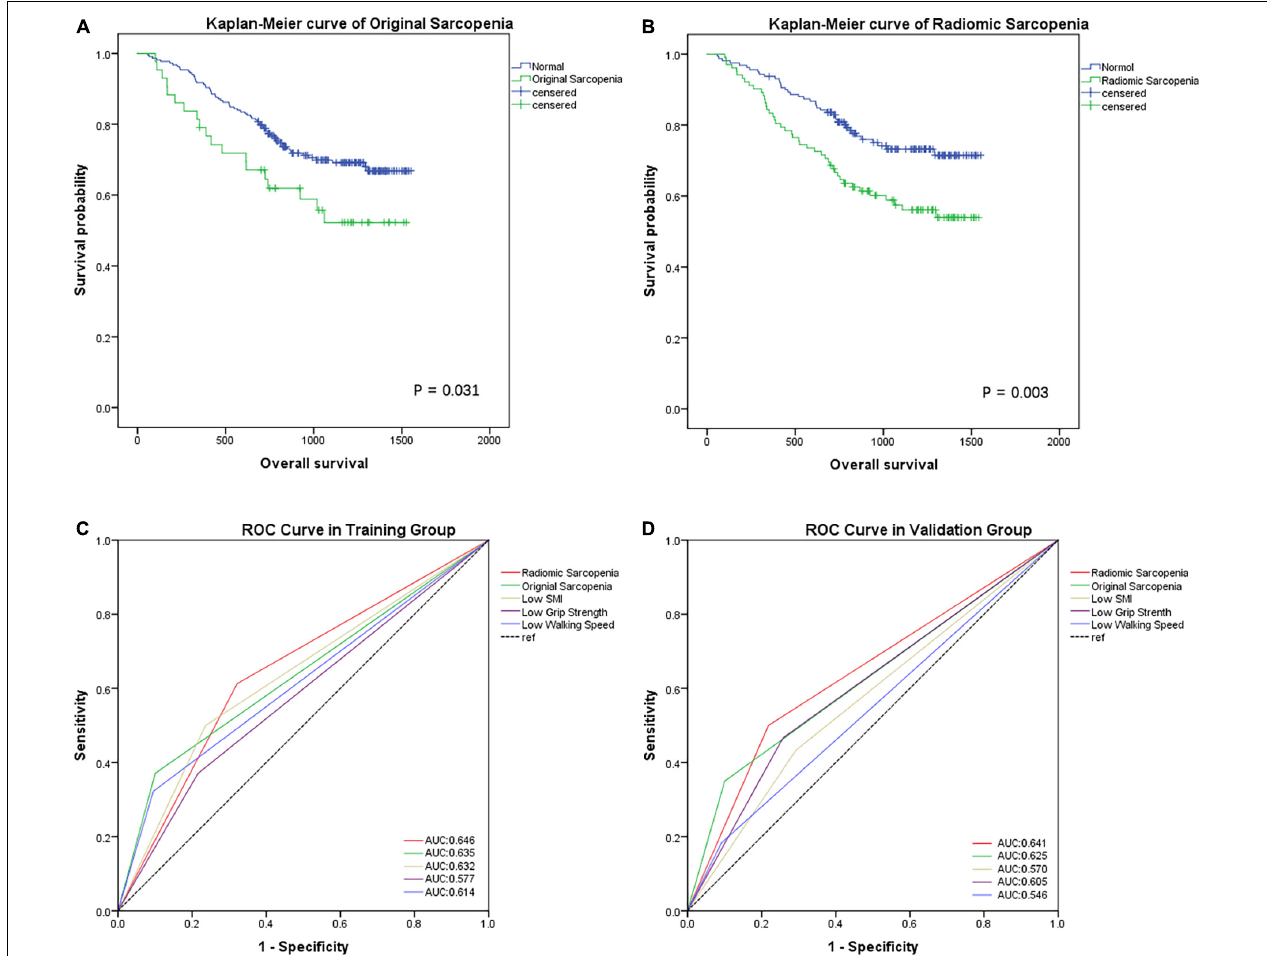
FIGURE 3 | Kaplan–Meier analysis for overall survival (days) of GC patients in the training group according to original sarcopenia (A) and radiomic sarcopenia (B) . ROC curves for the preoperative characteristics of different sarcopenia models according to short-term complications after gastrectomy in training group (C) and validation group (D)